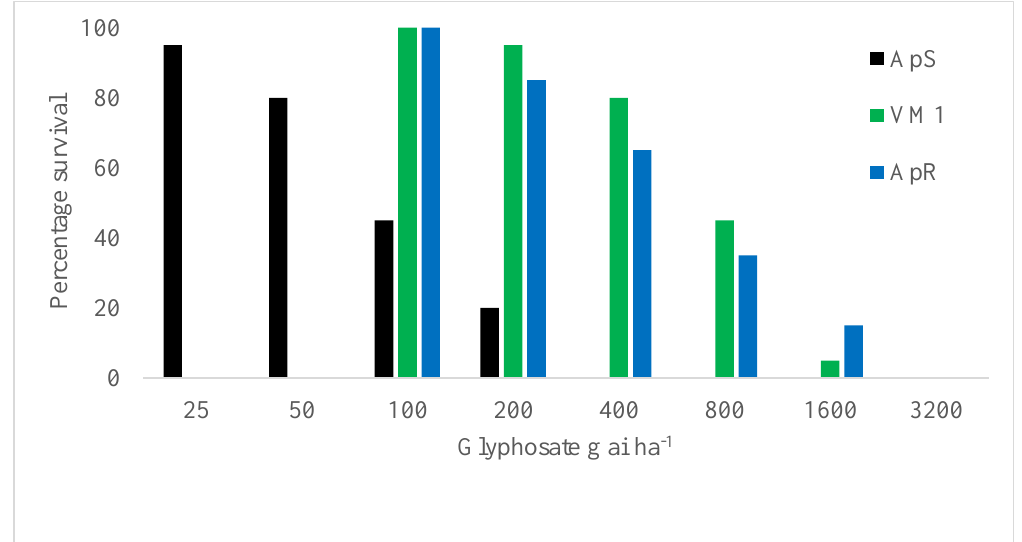
Figure 1. Glyphosate whole-plant dose–response test on VM1 compared with the known sensitive (ApS) and resistant (ApR: gene duplication) A. palmeri populations. Percentage survival assessed 21 days after glyphosate application.